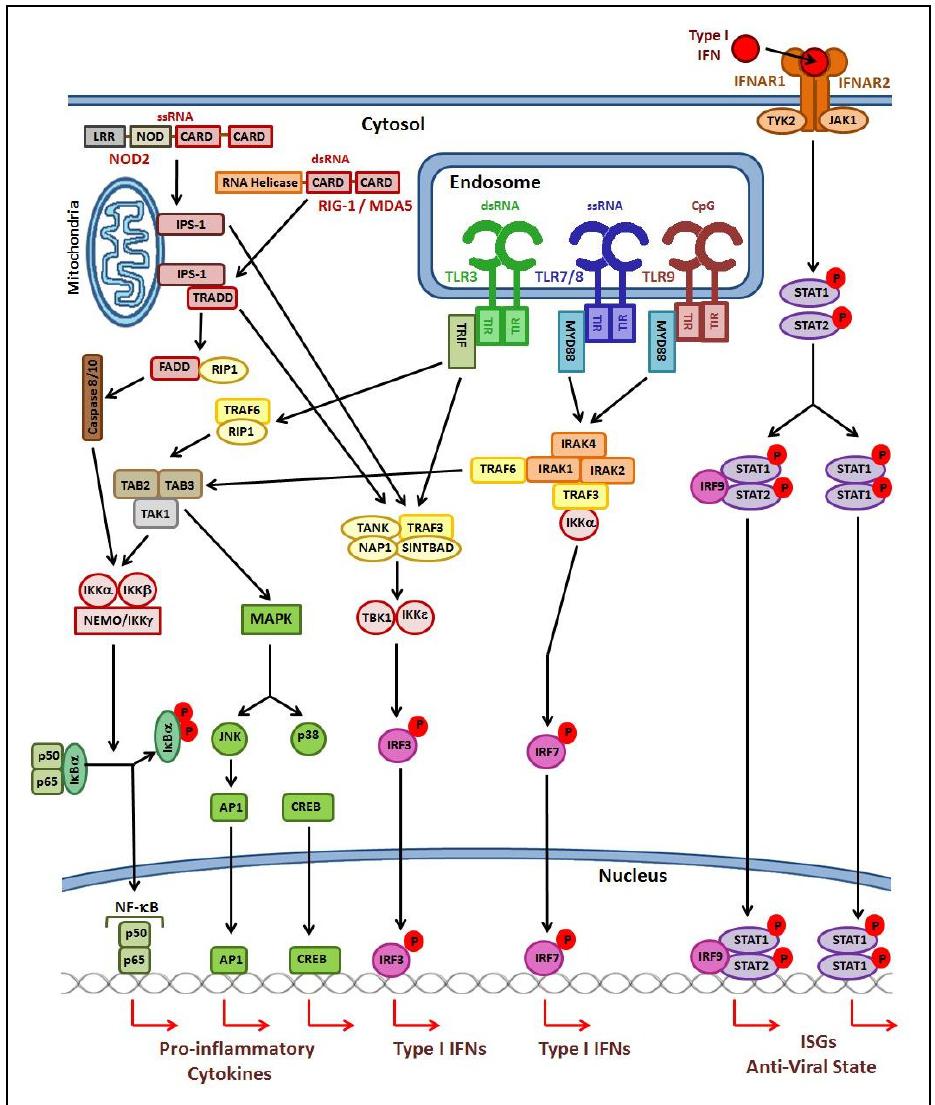
Figure 1. Pathogen recognition receptor signalling following viral infection. Ligand-induced dimerisation occurs following PAMP recognition by endosomal TLRs, which engages the Toll-IL-1 receptor (TIR) domains to initiate adaptor molecule recruitment and signal transduction. MYD88-dependent signalling results in the formation of an IRAK/TRAF6 complex, which phosphorylates IRF7 to initiate transcription of type I IFN genes, and activates a TAK1/TAB2/3 complex to drive transcription of pro-inflammatory cytokine genes via activation of NF-κB, AP1 and CREB. TRIF-dependent signalling can also activate NF-κB, AP-1 and CREB via recruitment of TRAF6 and RIP1. Alternatively, TRAF3 is recruited, resulting in phosphorylation of IRF3 which translocates into the nucleus to induce expression of type I IFNs. RIG-I and MDA5 are also able to activate NF-κB and IRF3 via interaction with IPS-1 localized on the mitochondrial membrane through homophilic interactions between their CARD domains. Similarly, CARD domains of NOD2 also interact with IPS-1 resulting in transcription of type I IFN genes. The type I IFNs produced bind to their receptor, and, via STAT-mediating signalling, initiate gene